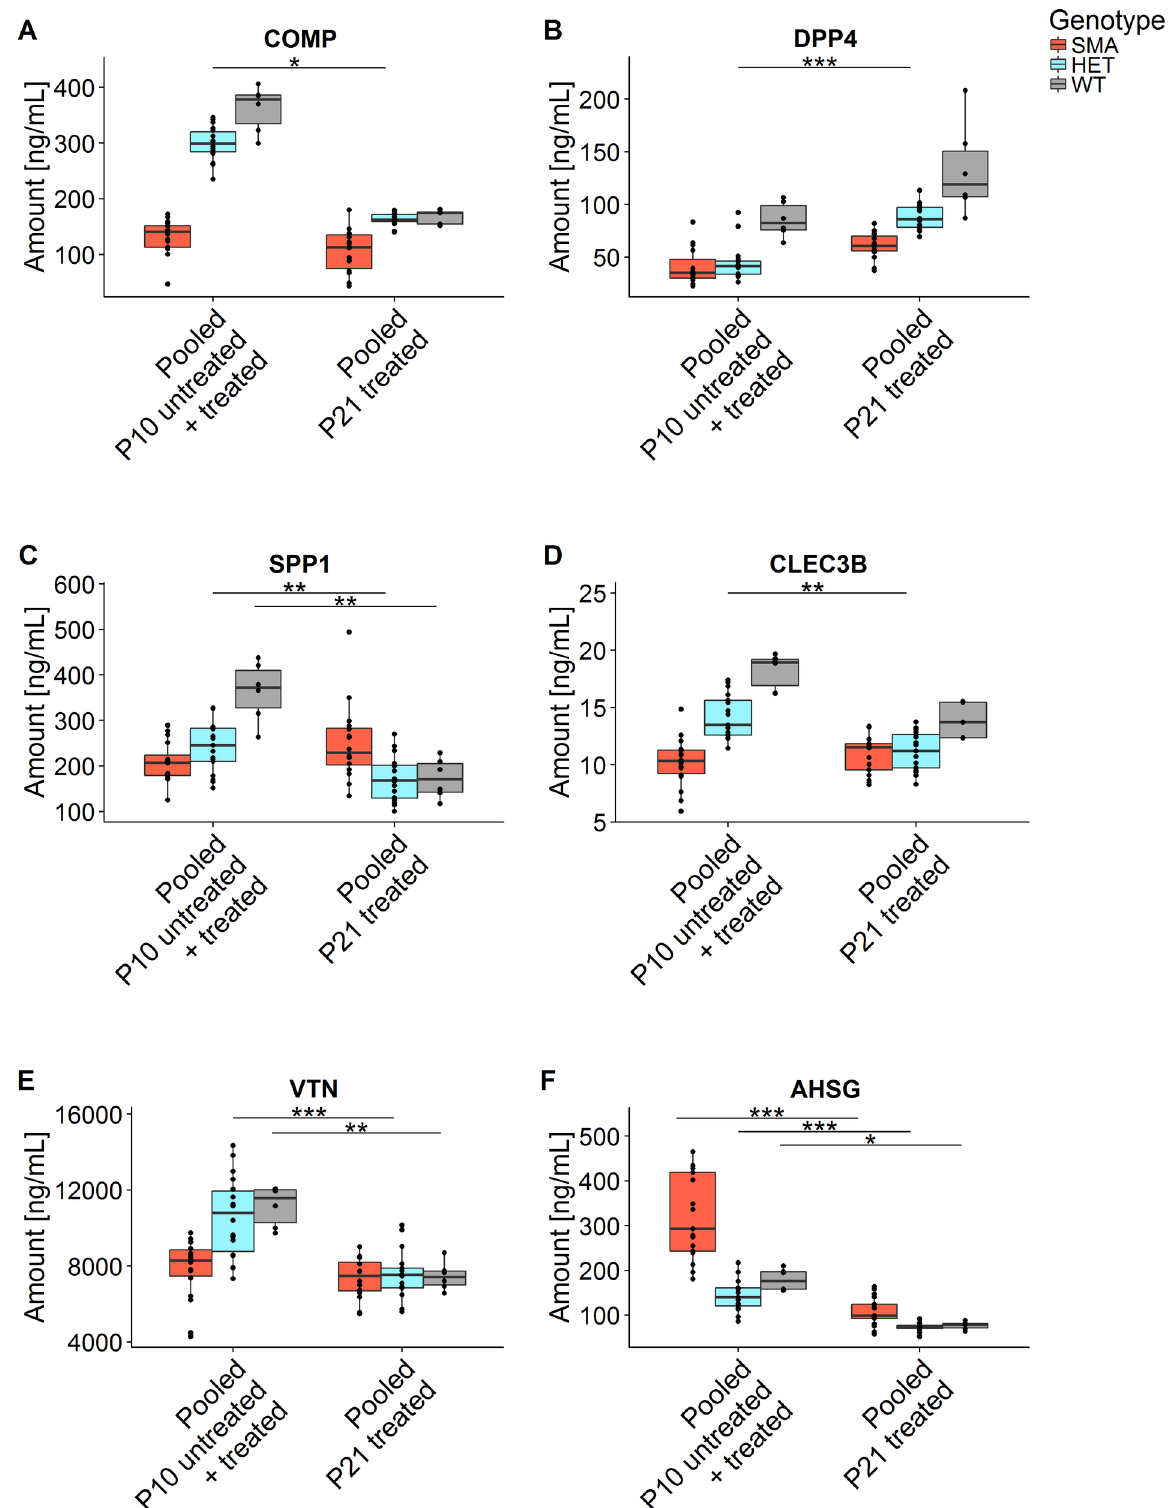
Fig 7. Longitudinal comparisons of P10 with P21 of pooled protein plasma concentrations of six putative biomarkers. Pooled untreated and SMN-ASO treated groups at P10 were longitudinally compared with pooled P21-treated groups for each genotype. Diagrams show (A) COMP, (B) DPP4, (C) SPP1, (D) CLEC3B, (E) VTN and (F) AHSG (see also S10 Table). (Dunn tests, Holm-corrected for multiple comparisons). Only comparisons leading to a significant difference are shown ( (cid:3) P (cid:20) 0.05; (cid:3)(cid:3) P (cid:20) 0.01, (cid:3)(cid:3)(cid:3) P (cid:20) 0.001).